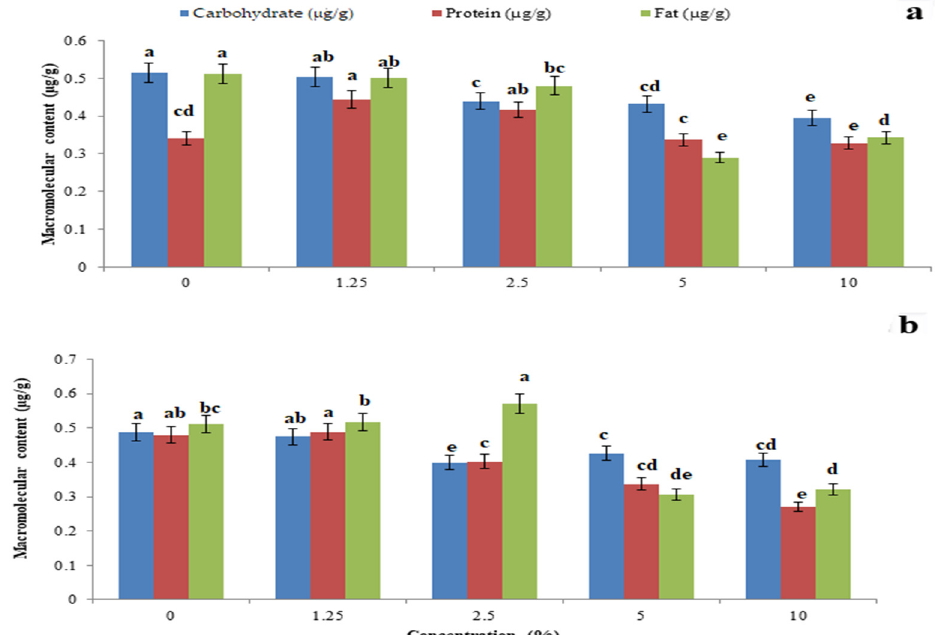
Figure 7. Whole-body carbohydrate, protein, and fat ( µ g/g) of P. solenopsis exposed to different concentrations of A. squamosa ( a ) and A. squamosa- AgNPs ( b ). Different letters (among the same concentration for each enzyme separately) above bars indicate significantly different means according to Tukey’s test ( p < 0.05). Bars indicate the standard error (SE).